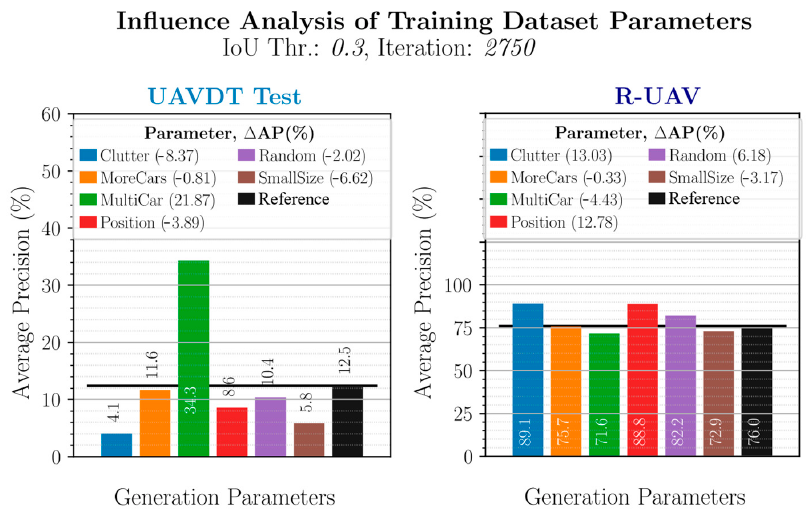
Figure 12. Comparison of the in fl uence of di ff erent parameter variations in the synthetic training data generation on the performance of the detector model on the UAVDT and the R-UAV test data. In each case, the legend shows the change in AP compared to the reference model.